Question: Write a single sentence explaining what this figure depicts.
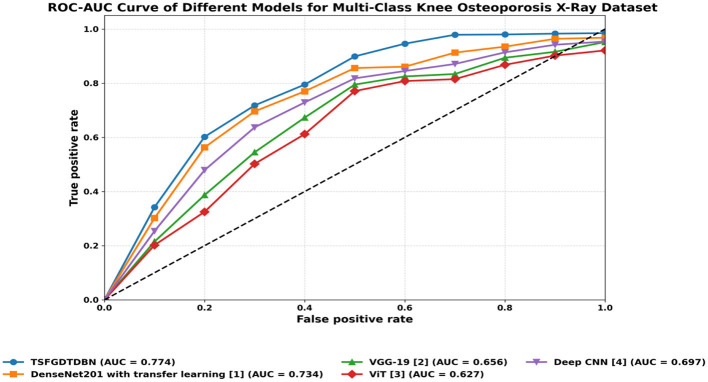
Answer: Performance analysis of ROC-AUC Curve results using Multi-Class Knee Osteoporosis X-ray Dataset.